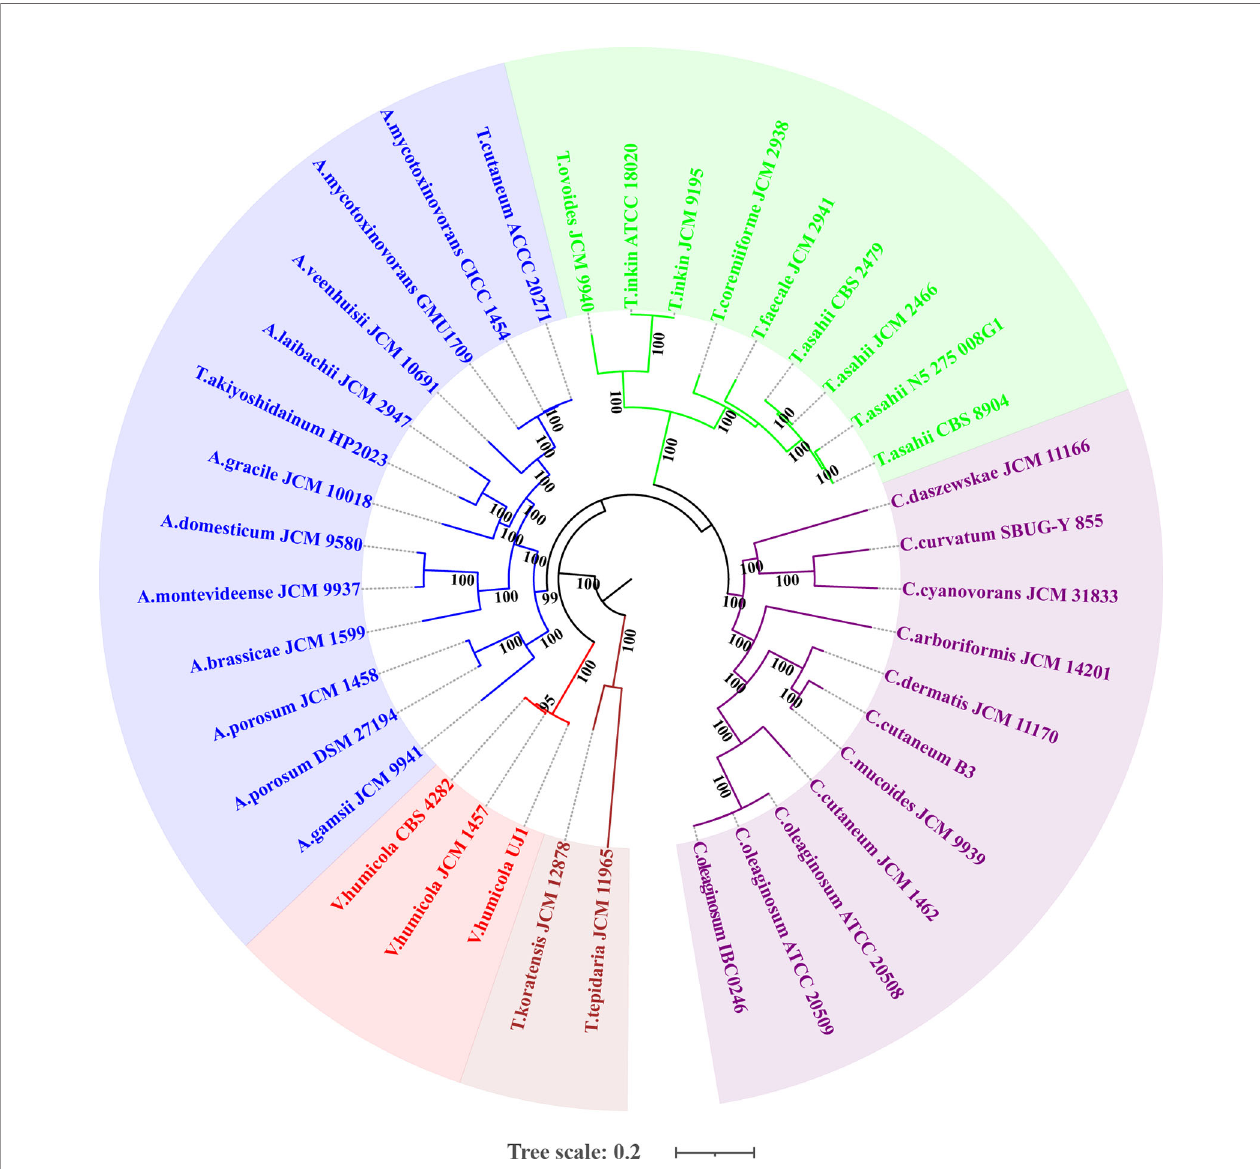
FIGURE 2 | Maximum likelihood (ML)-based phylogenomic analysis of thirty-six Trichosporonaceae members. The ML tree is inferred from the concatenated non- gaped sites of multiple whole-genome alignments. The phylogeny is generated using raxmlHPC-PTHREADS-AVX version 8.2.10 based on the GTRGAMMA model and 100 bootstrap replicates. The genera Apiotrichum , Trichosporon , Cutaneotrichosporon , Vanrija in the family Trichosporonaceae and the genus Takashimella (outgroup) in Tetragoniomycetaceae are highlighted in blue, green, purple, red, and brown